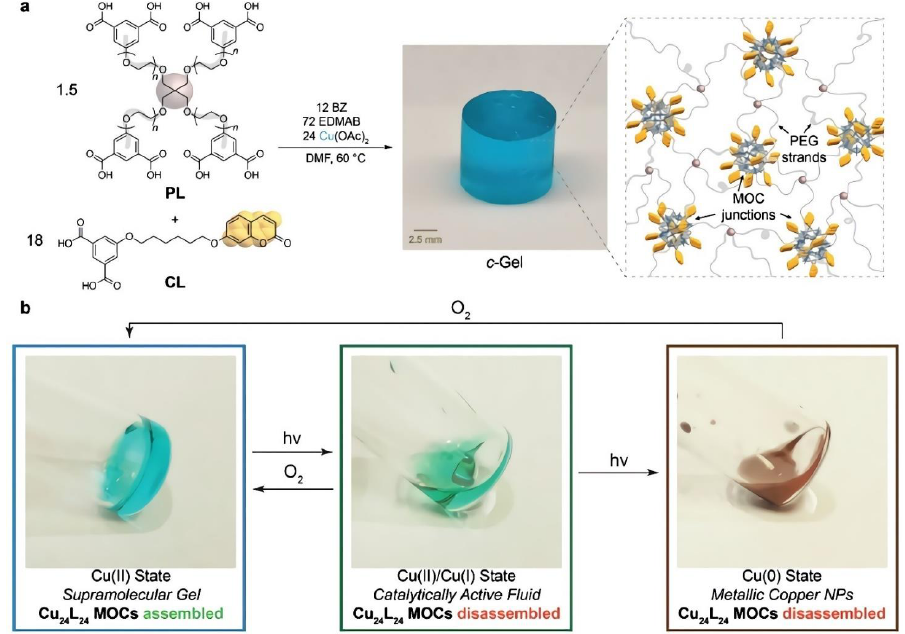
Figure 2. Design of Cu 24 L 24 -based polyMOCs featuring coumarin-functionalized junctions. ( a ) m - BDC-functionalized PEG star polymer PL and coumarin-functionalized m -BDC (CL) are combined with Cu(OAc) 2 , dimethylformamide (DMF, solvent), benzophenone (BZ, photosensitizer), and ethyl-4-(dimethylamino)benzoate (EDMAB, H-atom donor). Annealing provides coumarin-functionalized polyMOC c -Gel, composed of Cu 24 L 24 junctions decorated with coumarins and polymer strands from CL and PL, respectively. ( b ) Photoreduction or air oxidation enables reversible interconversion of c -Gel between Cu II , Cu I , and Cu 0 functional states with corresponding gel–sol transitions and differences in catalytic activity. Reproduced with the permission of Wiley-VCH Verlag GmbH &